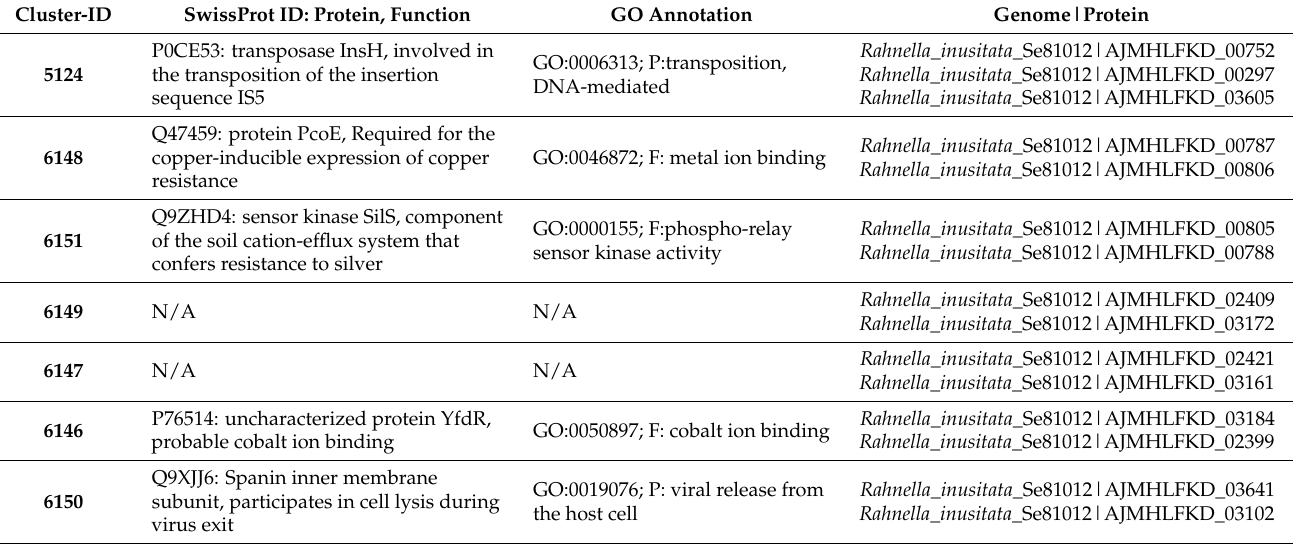
Table 1. Summary of main unique clusters found in the Antarctic Rahnella inusitata Se8.10.12 strain by gene ontology comparative analysis, including annotated clusters related to metal